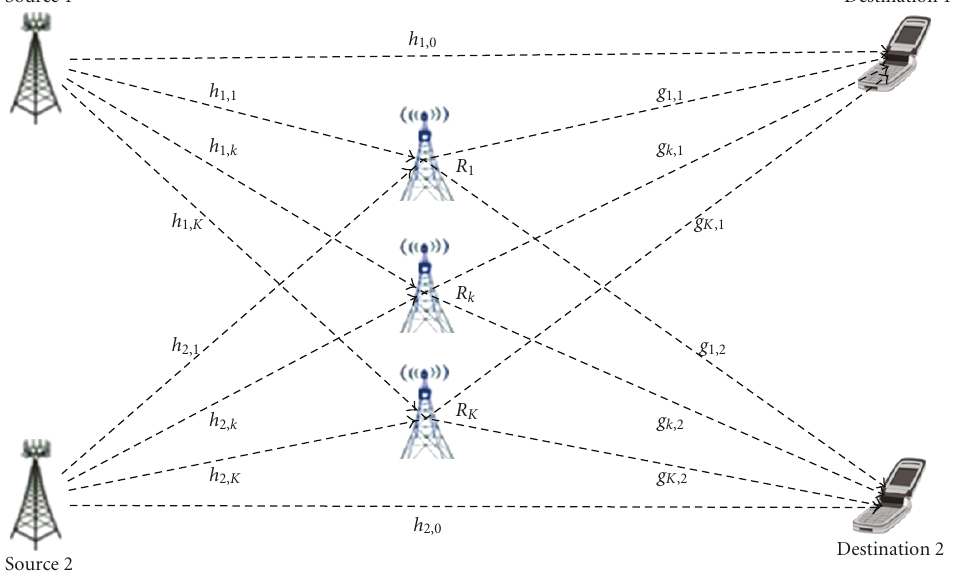
Figure 1: The multi-cast system